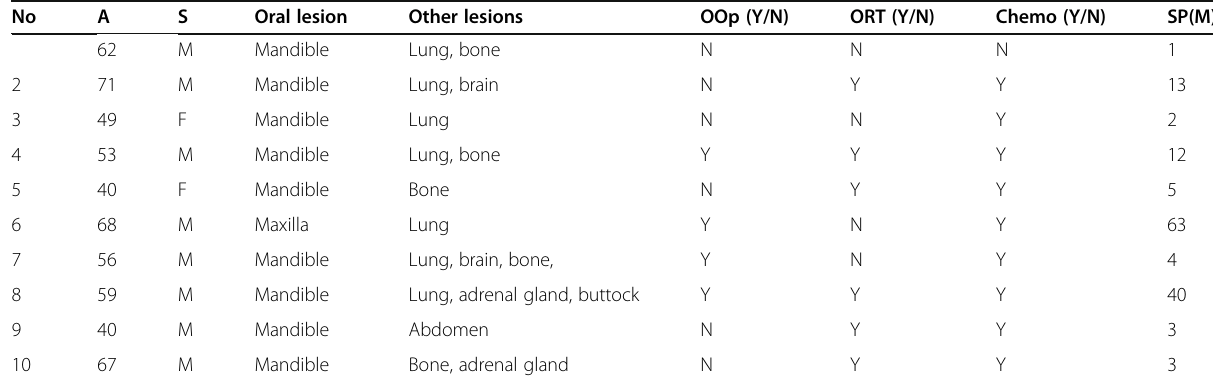
Table 1 Summary of the survival and treatment of the 10 oral MHCC patients